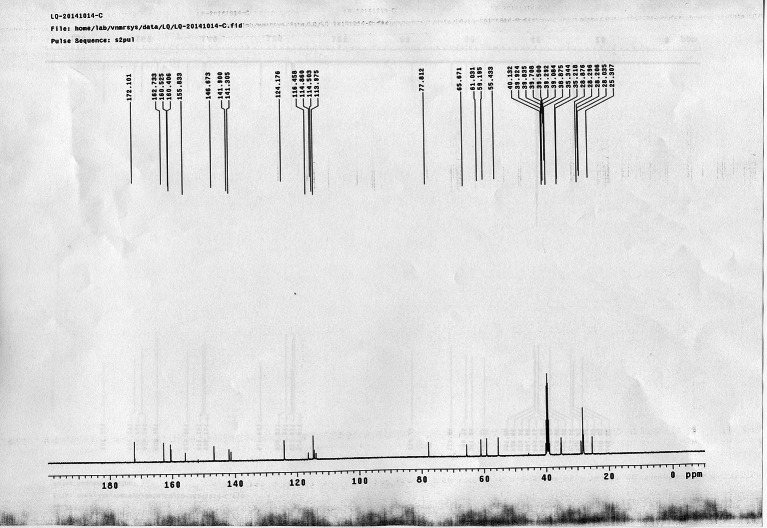
13C NMR spectra of compound 25.